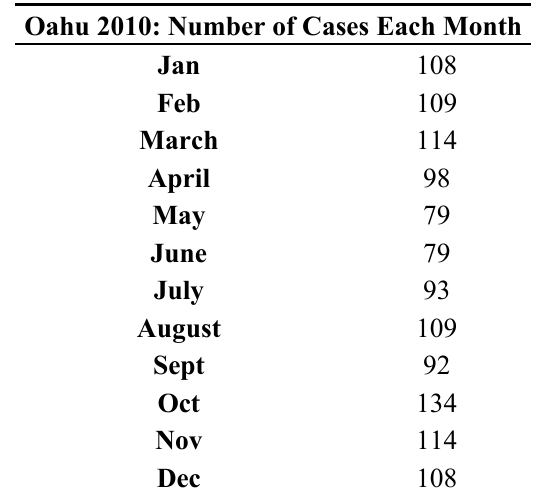
Table 11. 1,245 cases of food epidemic in 2010 at Oahu